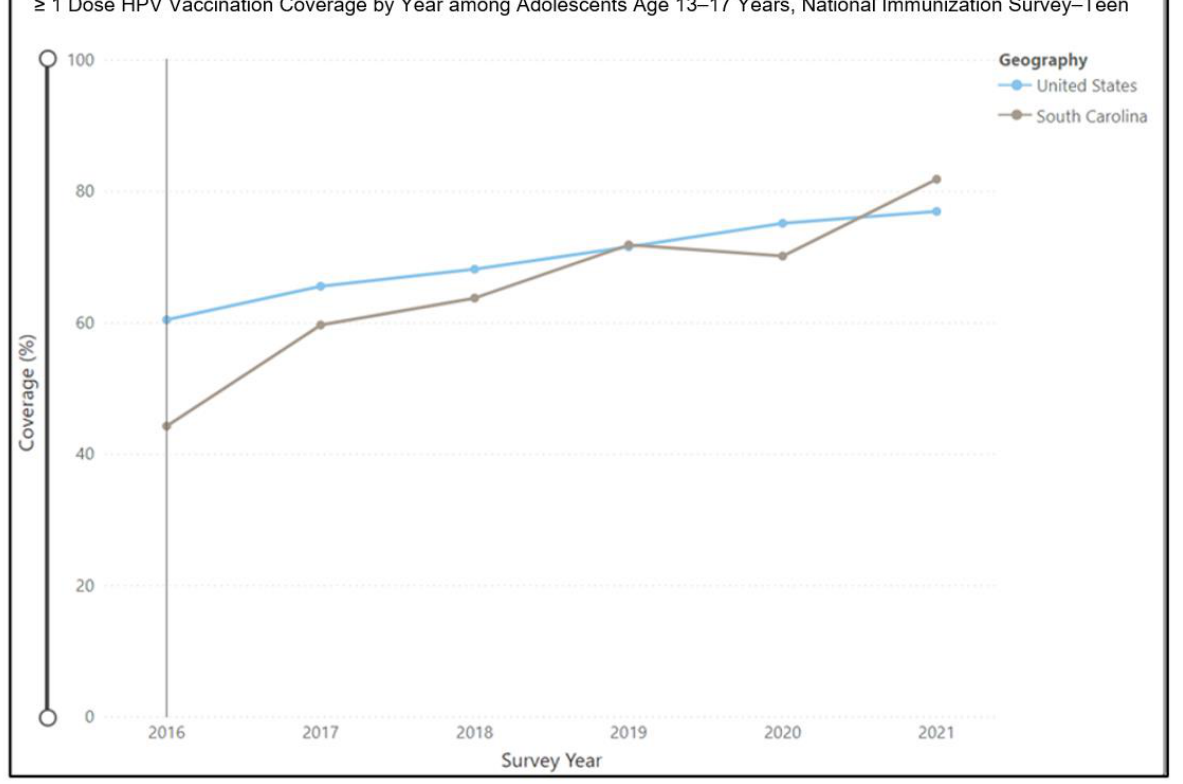
Figure 1. HPV vaccination rates in the United States and in South Carolina.